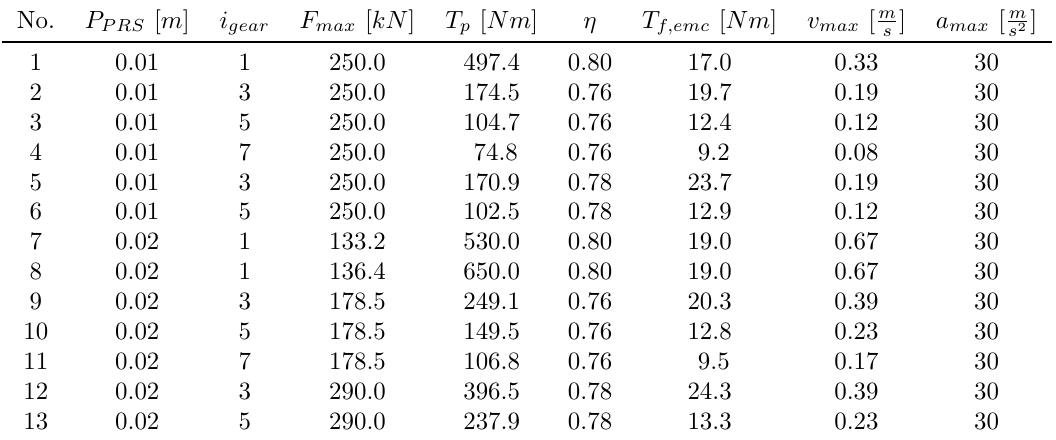
Table 2: EMC-HD-180 transmission system catalog data (Bosch Rexroth, 2015).